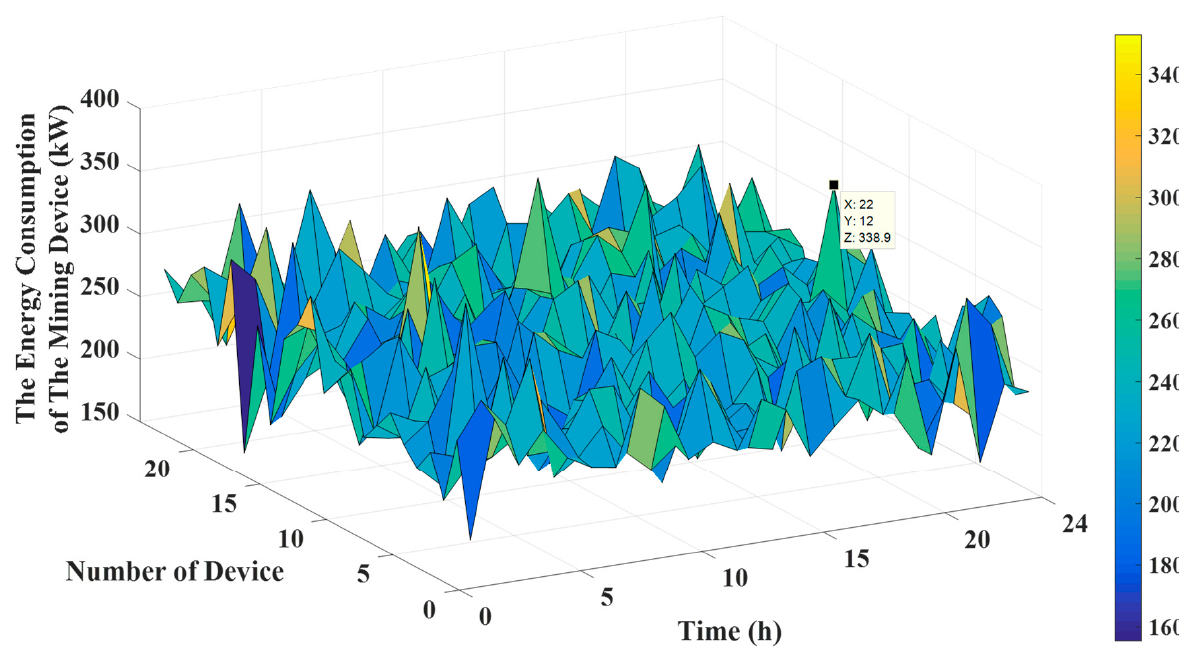
Figure 5. The energy consumption of the mining devices. Table 2. Comparative results for the total cost. Number of Case Total Operation Cost (¢)